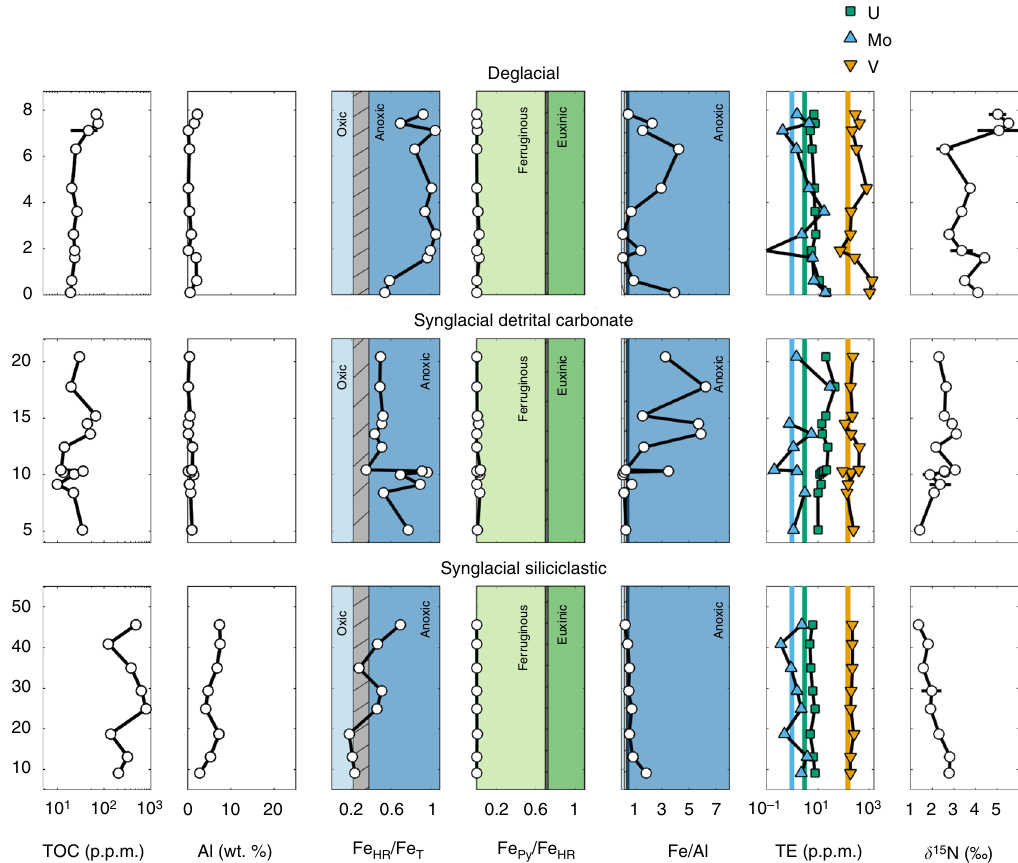
Fig. 2 Geochemical results. Organic carbon (TOC), Al, Fe-speciation, Fe/Al, redox-sensitive trace element (TE), and δ 15 N data shown for each section. TE are corrected for carbonate fraction (see text), all other data are whole rock. Iron speciation, with Fe HR /Fe T < 0.22 – 0.38 and Fe Py /Fe HR < 0.7, and Fe/Al ( > 0.55 ± 0.11) indicate primarily anoxic, ferruginous conditions, which would be required for scavenging TE. TE accumulated in the water column as a result of oxic continental weathering. TE data are shown compared to Post Archean Average Shale (PAAS) values for each element (coloured lines). Nitrogen isotopes are also consistent with the presence of oxygenated surface water. Error bars are s.d. of three repeated analyses for δ 15